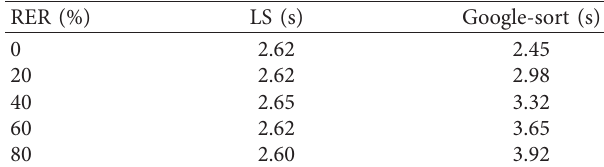
Table 3: Average time consumptions of LS and Google-sort al- gorithms on five RERs (in seconds).